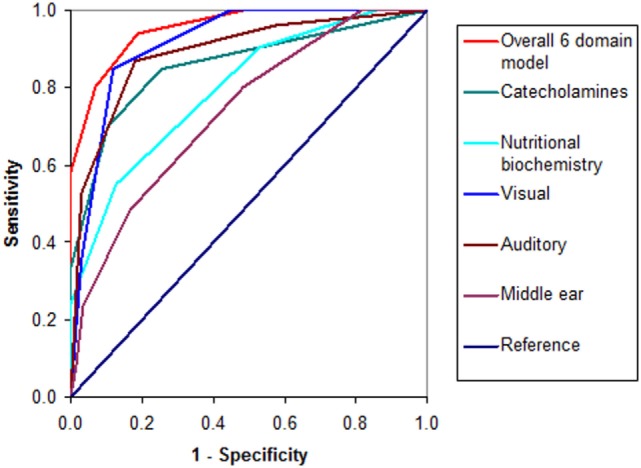
ROC curves for the 21 biomarker set.